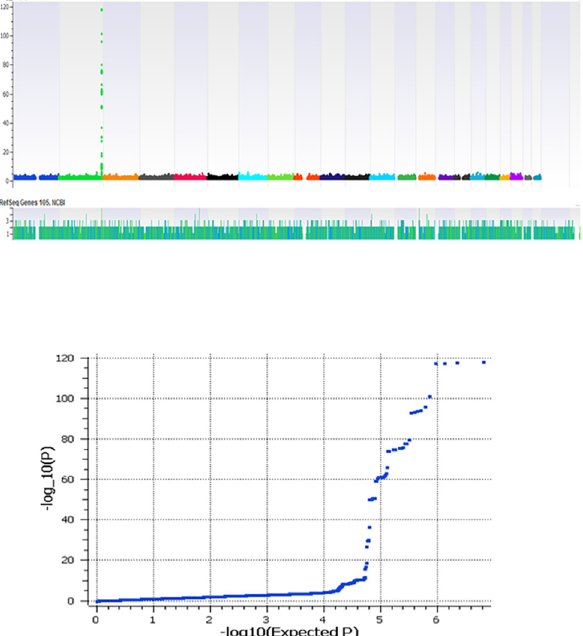
Fig 1. (A and B) Manhattan plot and Q – Q plot of genome-wide markers for total serum bilirubin in 3294 European samples respectively.